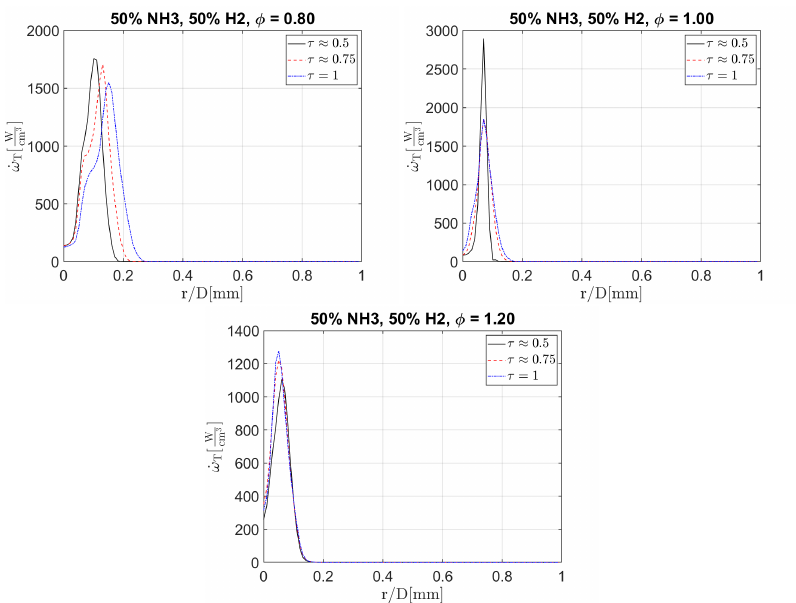
Figure 13. Conditional average of heat release averaged over r for 50%